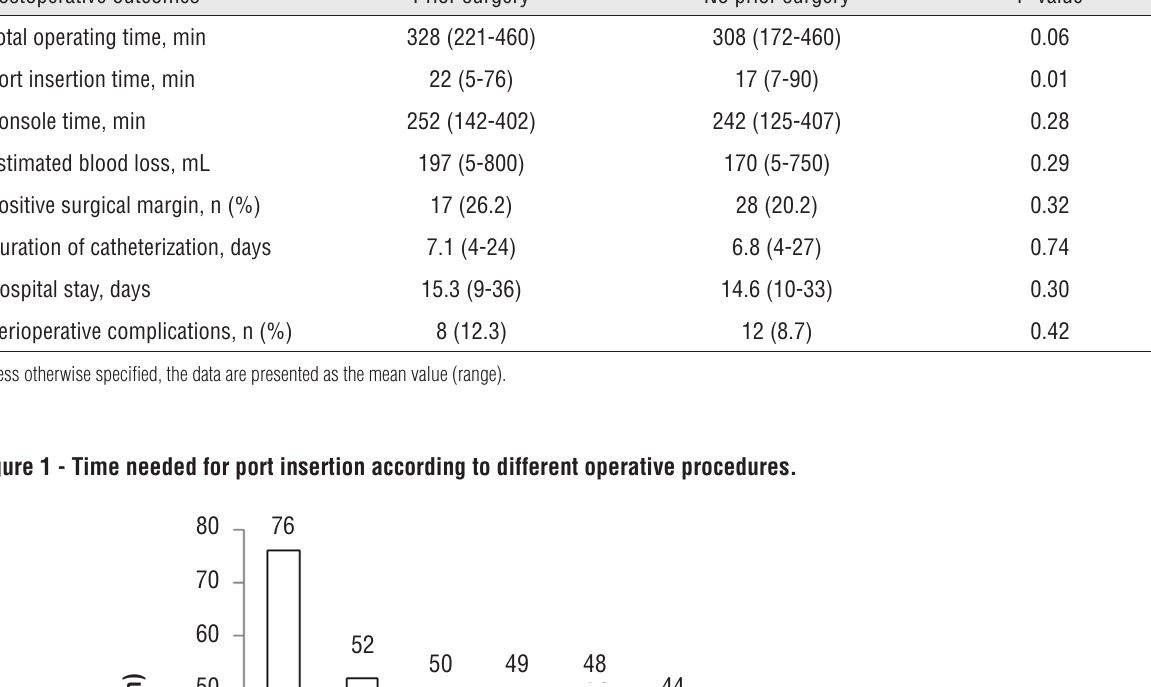
Table 3 - Comparison of patients with or without prior abdominal surgery. Postoperative outcomes